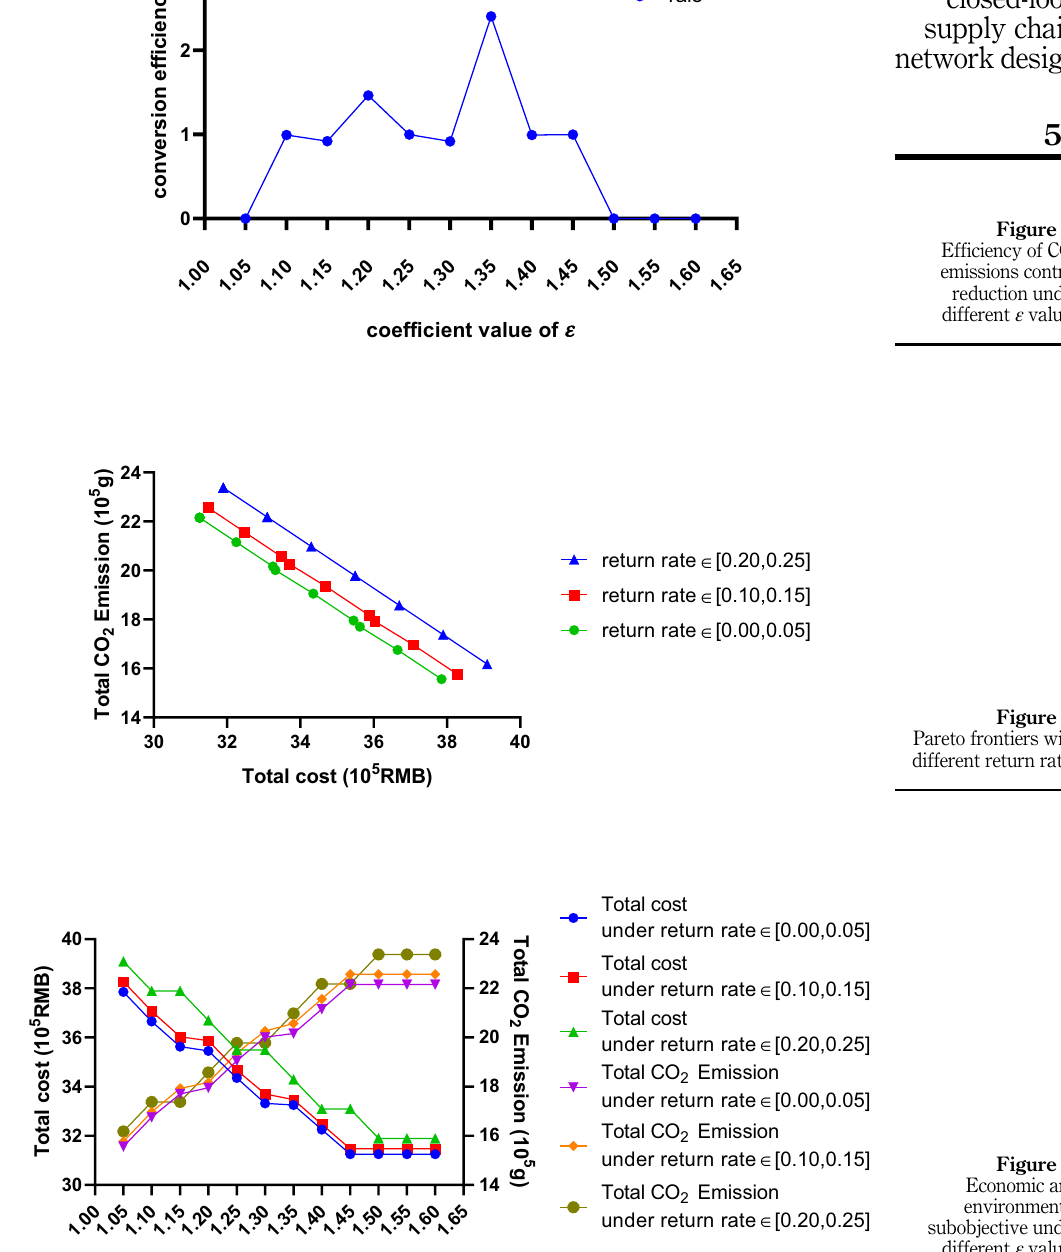
Figure 8. Economic